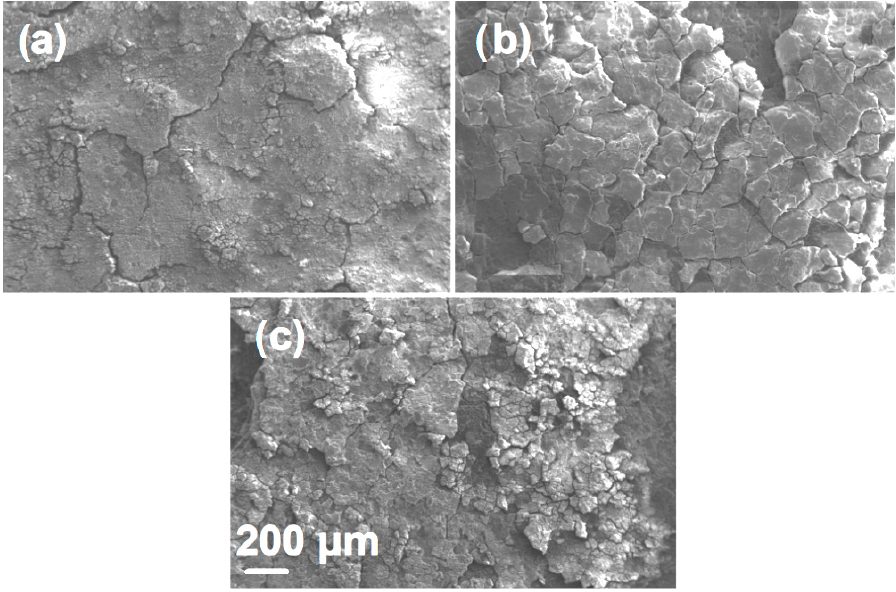
Figure 11. SEM micrographs of ( a ) Mg, ( b ) Mg65–Zn30–Ca5, and ( c ) Mg70–Zn25–Ca5 after potentiodynamic polarization tests.